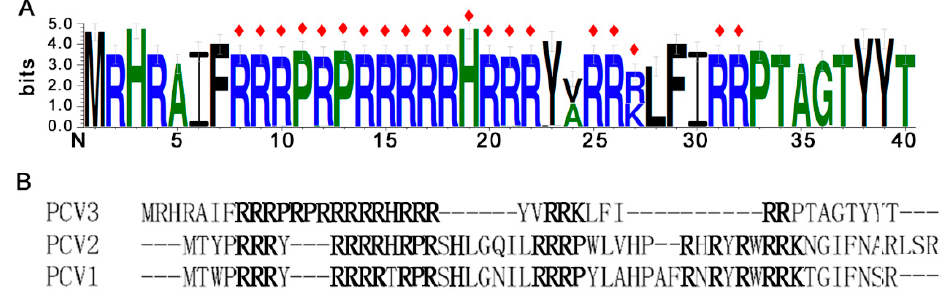
Figure 6. The variability of PCV3-ORF2 NLSs. ( A ) Logo of the N-terminal of all PCV3 ORF2 proteins (1–40 aa) reported and their complementary sequences, the nuclear localization signal peptide is showed by red ◊ . ( B ) The NLSs sequence alignment between PCV3 ORF2 and other PCVs is showed and the key amino acids are bold.